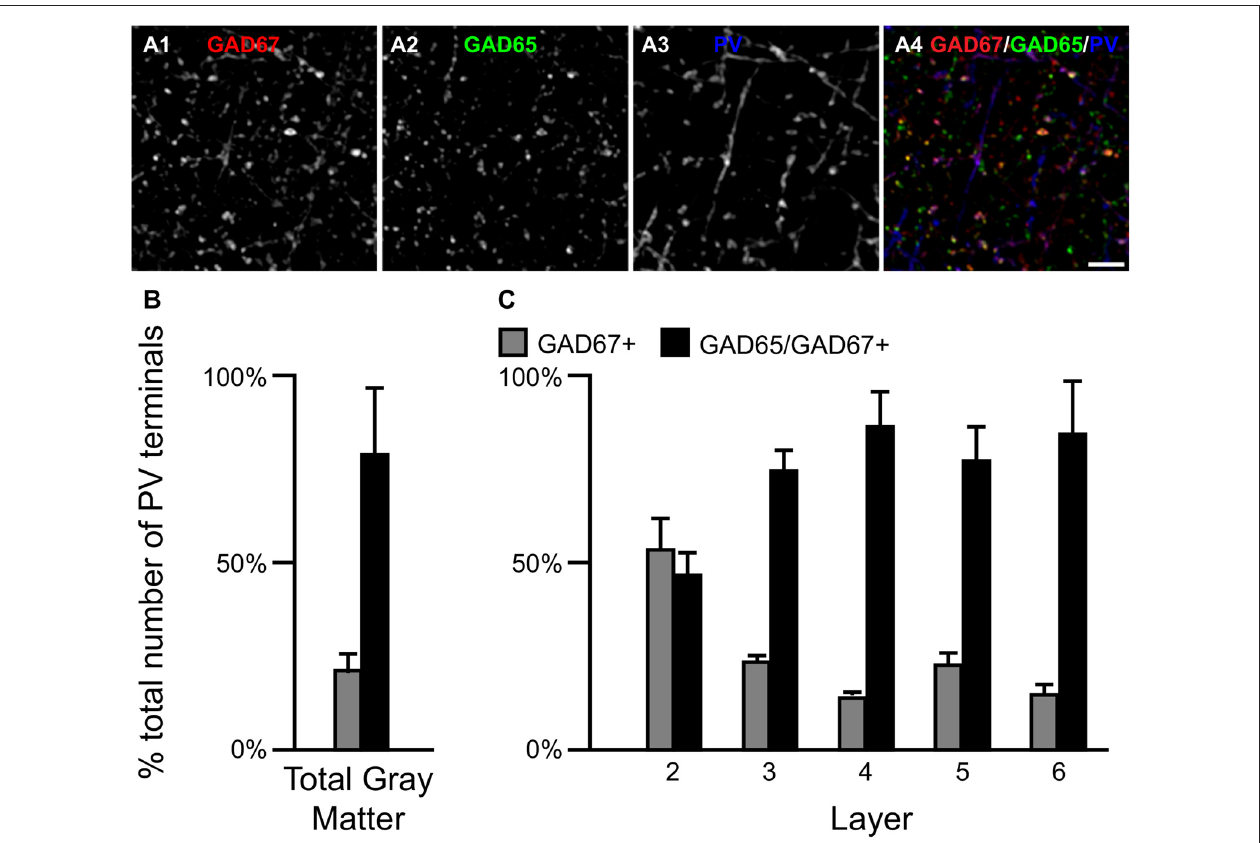
FIGURE 5 | The proportion of two PV/GAD+ terminal subpopulations differs across cortical layers. (A) Projection image (5 z-planes separated by 0.25 µ m) of a human PFC tissue section immunolabeled for PV, vGAT (not shown), GAD65 and GAD67. Gray scale images (A1–A3) are single channel images of the multichannel image (A4) and are representative of the immunohistochemistry labeling. Scale bar = 5 µ m. (B,C) Bar graphs showing the relative proportions of vGAT/PV+ terminals in PFC that were GAD67+ or GAD65/GAD67+. Error bars =